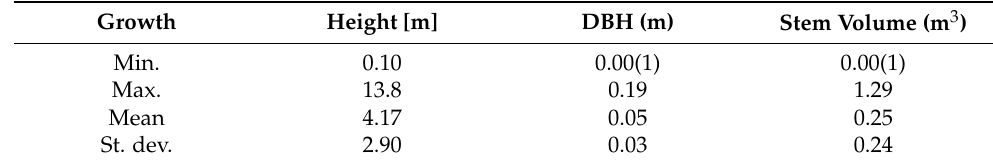
Table 1. The statistics of reference growth values derived for the 14 common plots after filtering out the fallen and broken trees and measurement errors. Growth Height [m] DBH (m) Min.